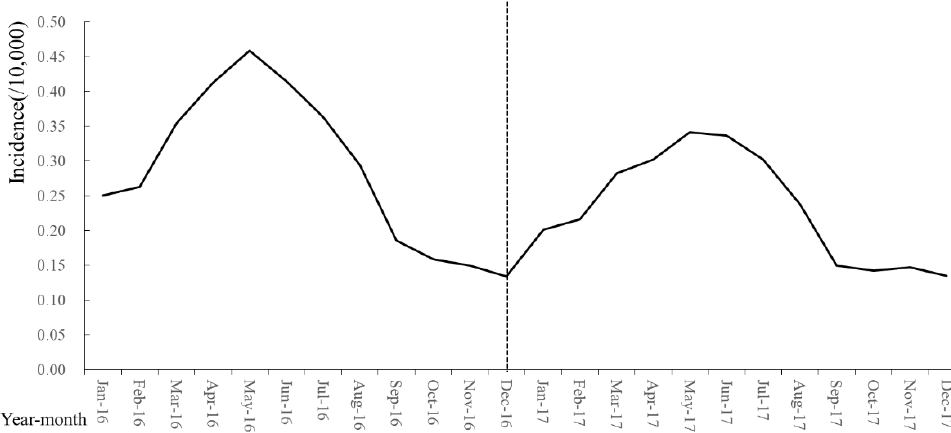
Figure 2. Monthly incidence of Brucellosis in China during 2016 – 2017. (The monthly incidence of patients was only available during 2016 – 2017.)